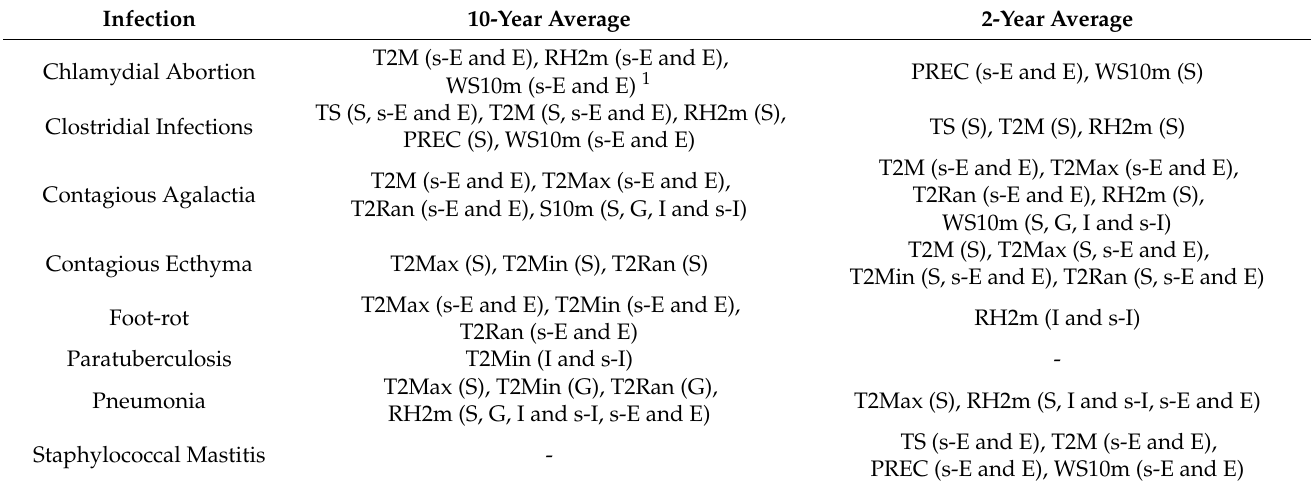
Table 3. Climatic parameters that were found to be associated with optional vaccination against eight infections in 444 small ruminant farms in